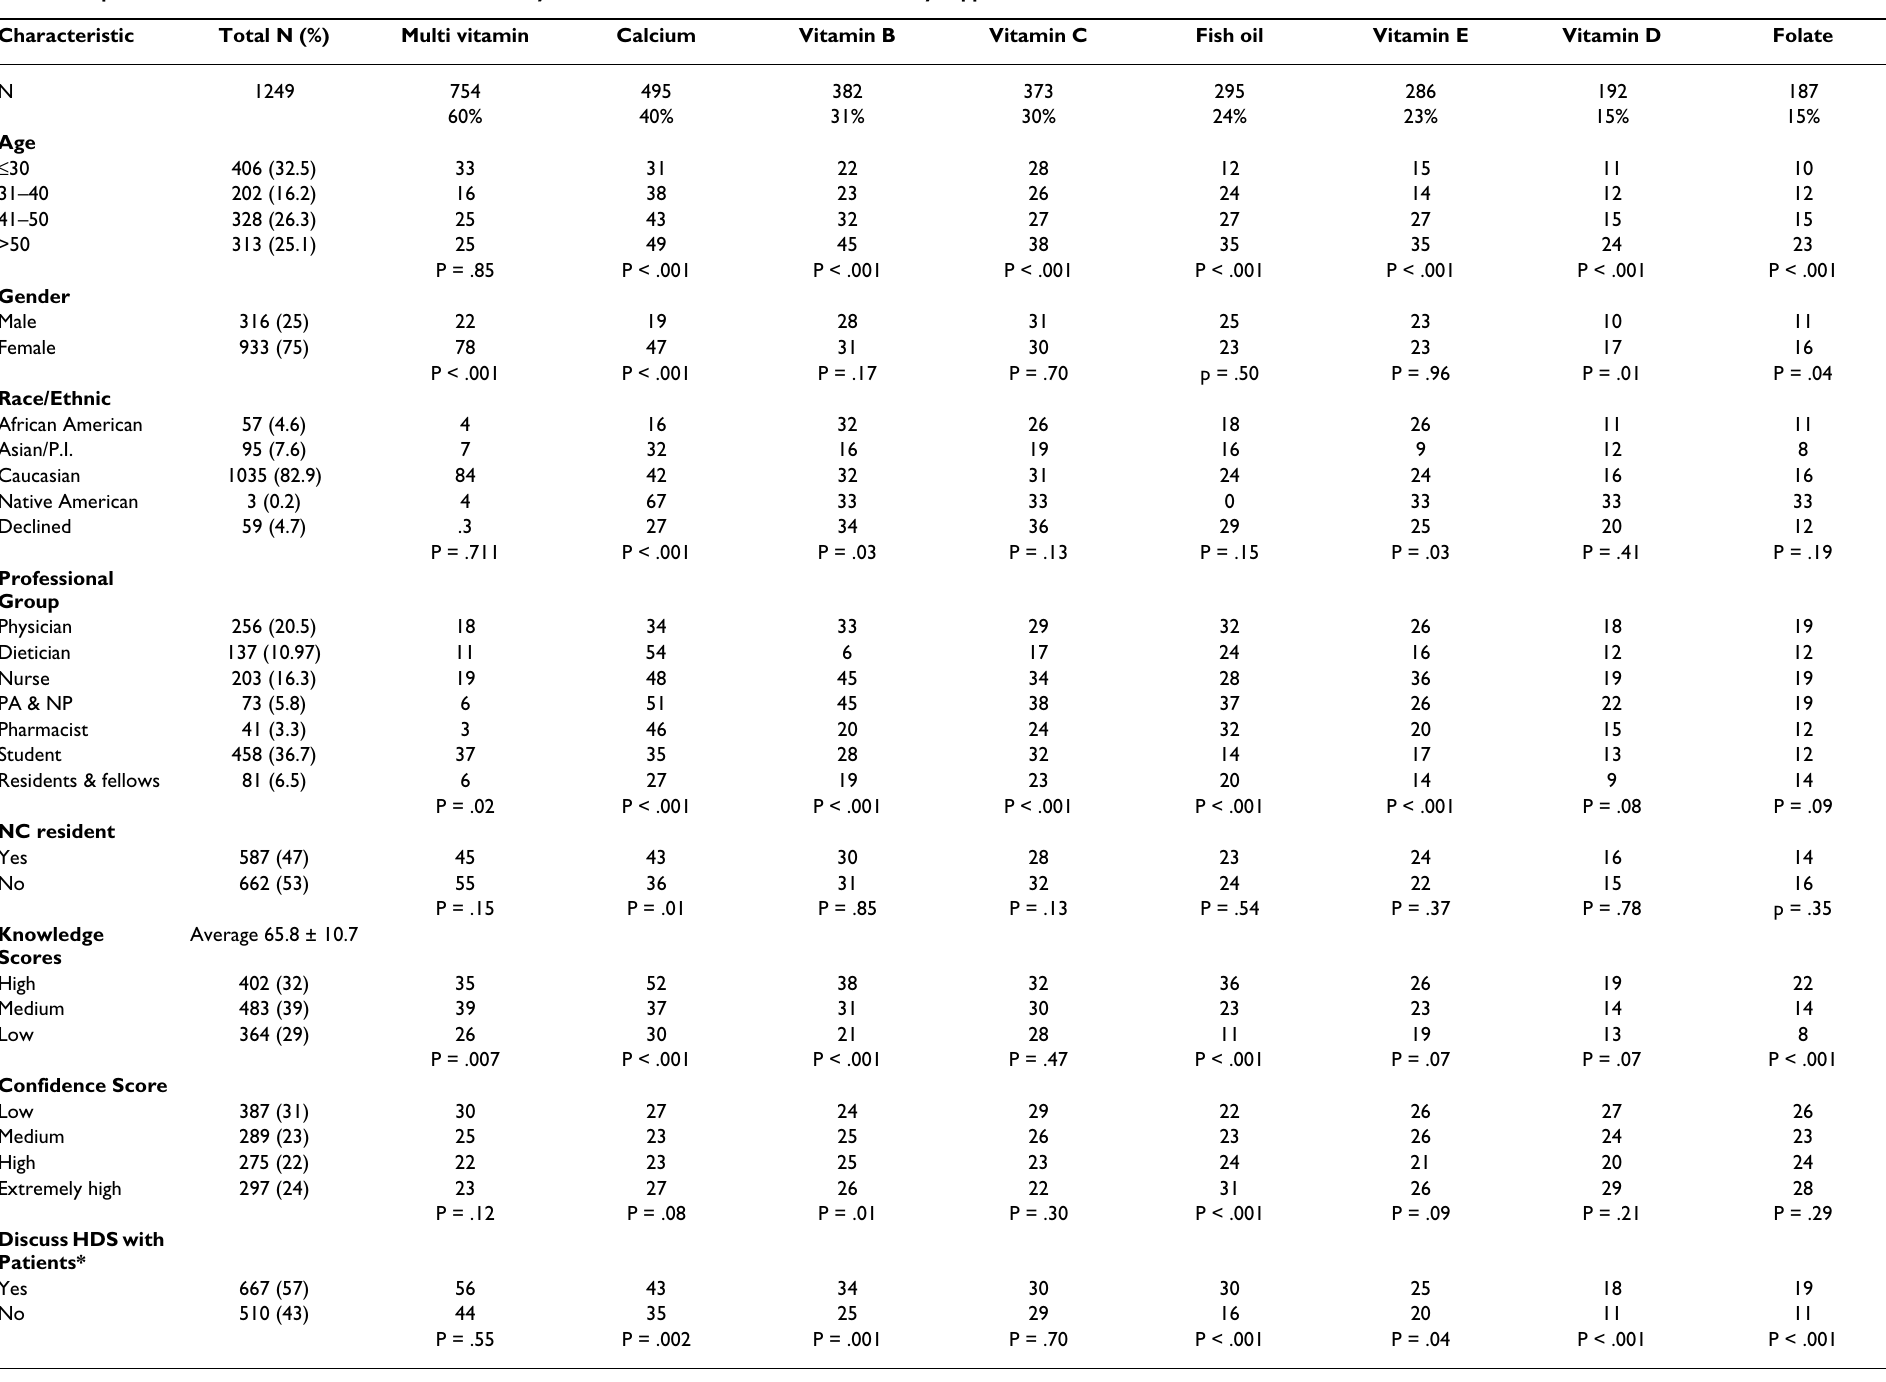
Table 2: Respondents baseline characteristics for commonly used vitamins minerals and other dietary supplements *